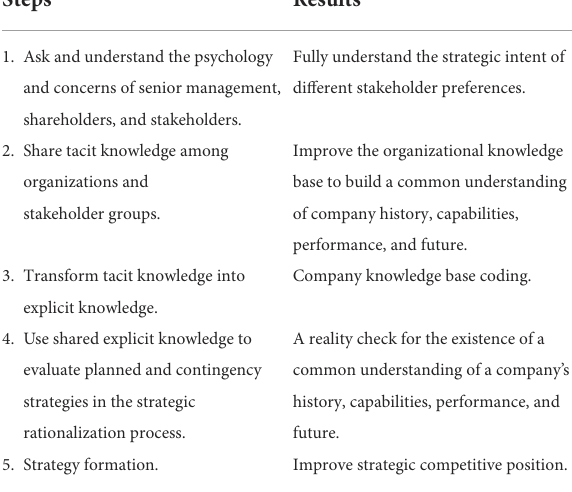
TABLE 3 Effective dialogue mechanism: steps and